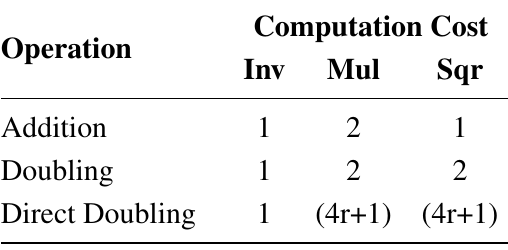
Table 9. Evaluation result of fixed-base scalar multiplication under the pair condition (in terms of table size), where A , D and DD ( w ) denote addition, doubling and direct doubling (width), respectively. Computation cost excludes the cost for look-up table construction, which is pre-computable, so the cost mainly includes group addition and